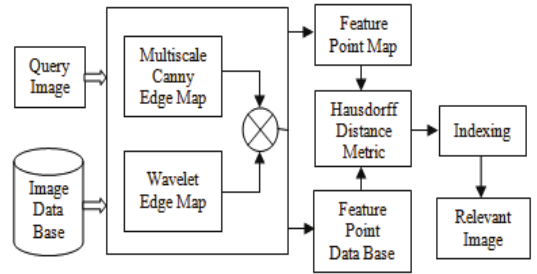
Figure 1: VSFPM based Image Retrieval